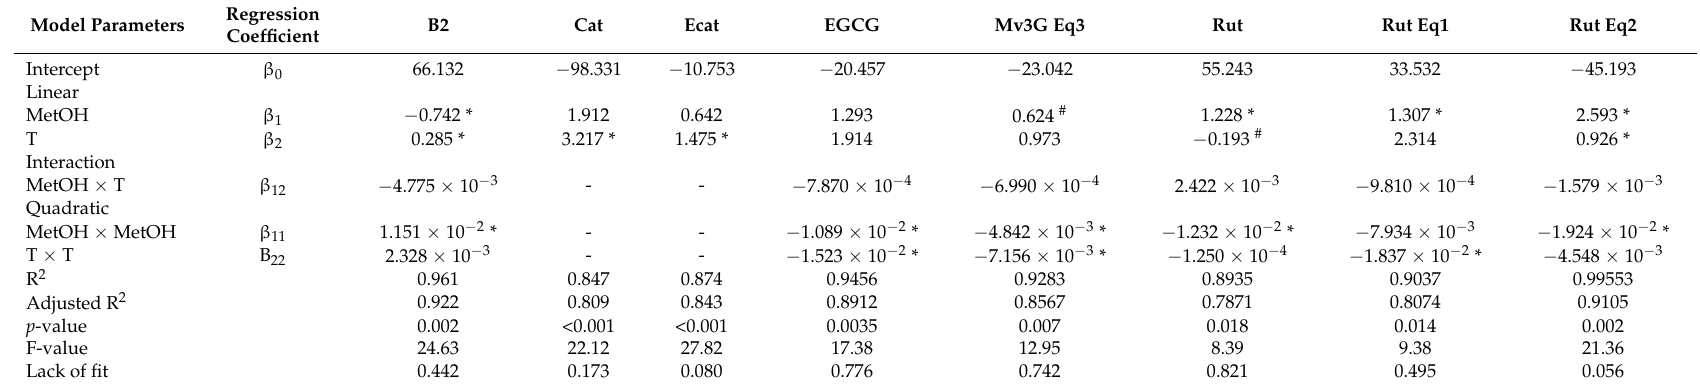
Table 2. Analysis of the variance and regression coefficients of the predicted model for the response variables of organic whole red Grenache grapes. Regression Model Parameters